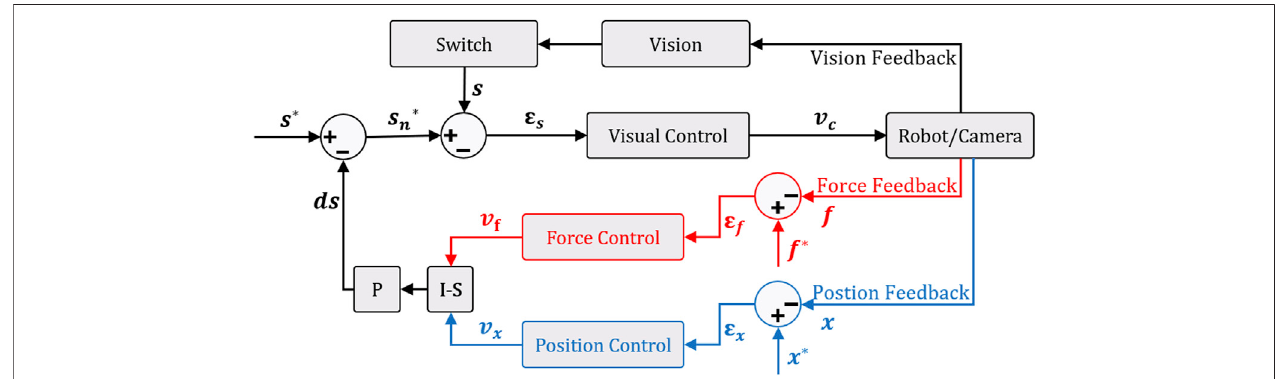
FIGURE 6 | External hybrid force/vision comanipulation (in red) and position/vision tele-operation (in blue) control scheme with the function of keeping the target in the center of the camera fi eld-of-view.